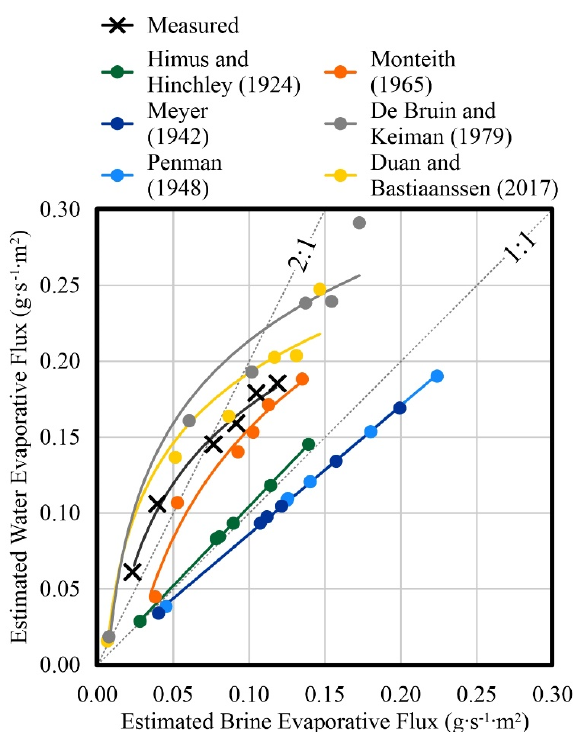
Figure 5. Comparison of evaporative fluxes from distilled water and saturated brine surfaces using various